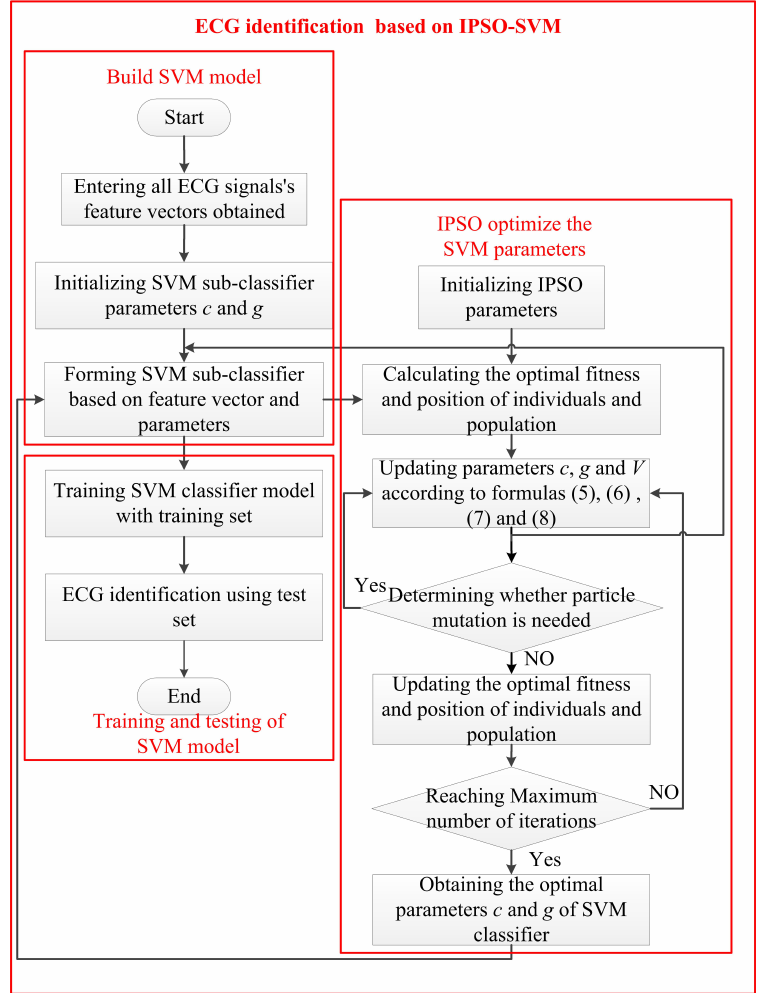
Figure 6. Block diagram of ECG identification based on